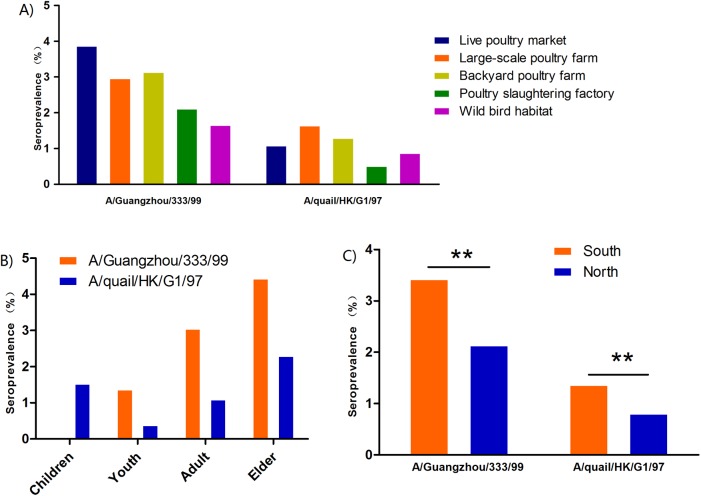
Comparison of seroprevalence from different human populations and regions in China.A) Comparison of the seropositivity of H9N2 viruses in occupationally exposed populations. The seropositivities among different occupationally exposed populations were significantly different for H9N2 viruses (p = 0.0023 for A/Guangzhou/333/99 (G9) and p = 0.041 for A/quail/Hong Kong/G1/97(G1)). B) Comparison of the seroprevalence of H9N2 viruses in different age groups. Children: aged up to 14; Youth: aged 15–24; Adult: aged 25–59; Elderly: aged over 60. The seroprevalences of H9N2 viruses in different age groups were significantly different (p<0.0001 for both H9N2 viruses). C) Comparison of the seroprevalence of H9N2 antigens in Northern and Southern China. ** indicates p≤0.001.